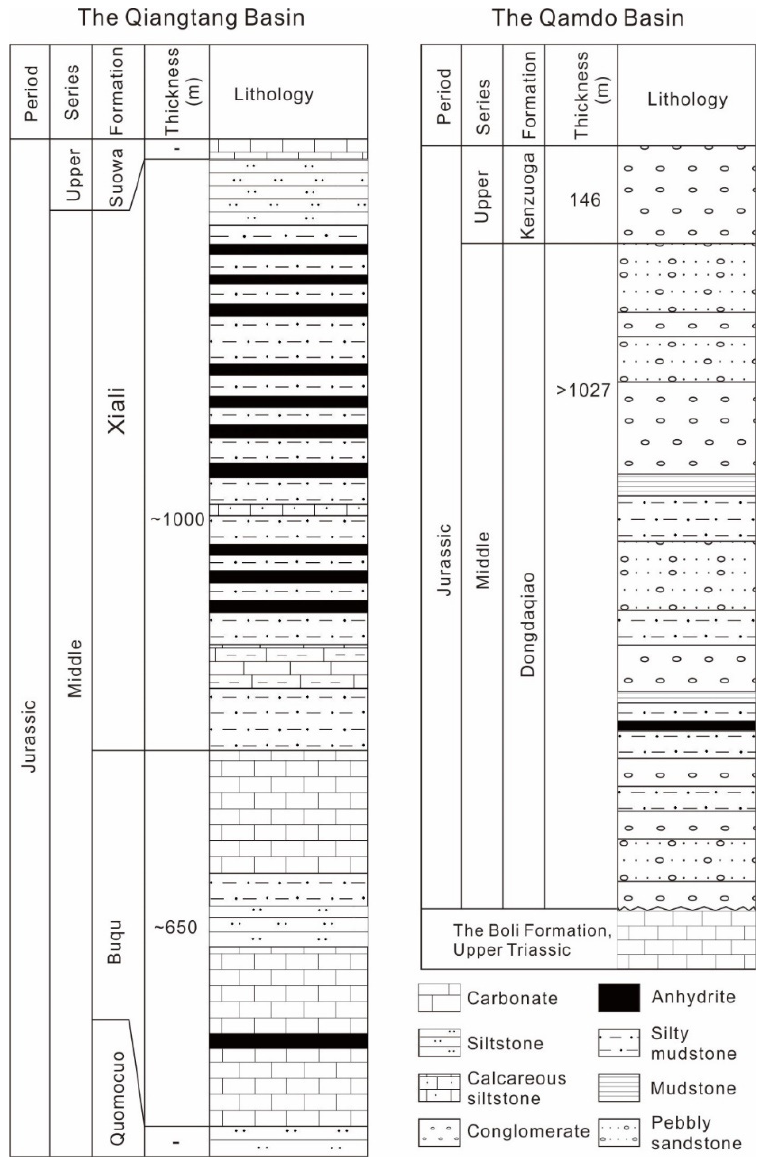
Figure 3. The lithostratigraphies of Middle Jurassic sedimentary sequences from the Qiangtang and Qamdo Basins (Modified from [19,21]).